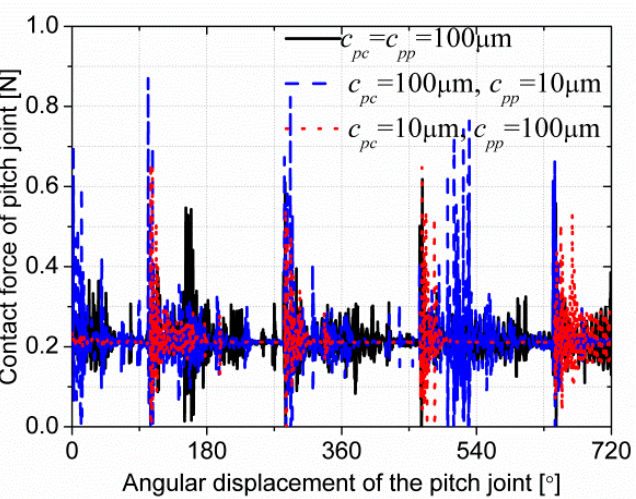
Figure 8. The radial contact force of pitch joint with different radial clearance. In Figure 7, when the radial clearance of the planetary gear of the azimuth joint c ap is 10 µ m, the value of the radial contact force is greatly reduced. The radial contact force is greatly reduced in value, and the curve changes continuously and smoothly, with only small changes, which indicates that the radial clearance of the planetary gear is the main factor that causes the radial contact force of the azimuth joint to change. When the radial clearance of the planet carrier of the azimuth joint c ac is 10 µ m, the radial contact force does not fluctuate greatly, and there is no small change. That is, the small change in the contact force of the azimuth joint is caused by the radial clearance of the planet carrier. The same law also exists in the pitch joint. Although the radial force curve of the red dot line